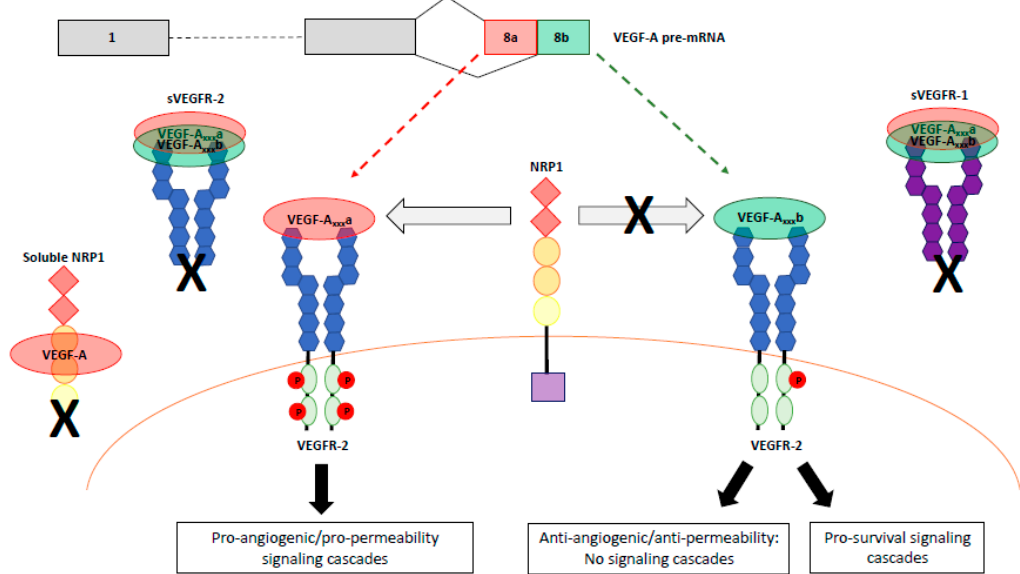
Figure 3. VEGF-A xxx a and VEGF-A xxx b signaling through VEGFR splice variants and NRP1. Both VEGF-A xxx a and VEGF-A xxx b can bind and dimerize VEGFR-2. VEGF-A xxx a recruits NRP1, a co-receptor for VEGFR-2, which results in phosphorylation of the tyrosine kinase domains of VEGFR-2, producing pro-angiogenic and pro-permeability intracellular signaling cascades. In contrast, VEGF-A xxx b is unable to recruit NRP1, resulting in weak, transient phosphorylation of VEGFR-2 and some pro-survival signaling cascades. Soluble isoforms of NRP1, as well as sVEGFR-2 and sVEGFR-1 lack transmembrane domains and act as decoy receptors, sequestering VEGF-A.